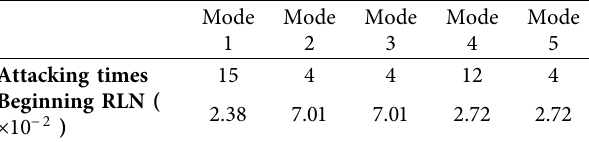
Figure 13: Rln of physical nodes of three